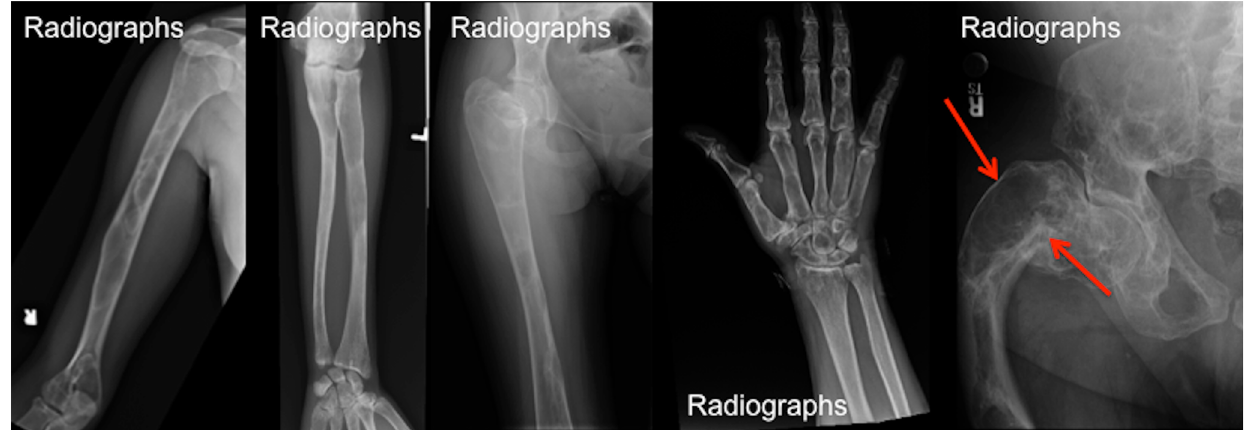
Fig. 5 The radiographic appearance of fibrous dysplasia (FD) and the rind sign. a – e Frontal radiographs demonstrate classic FD lesions in appendicular skeleton. A classic lucent lesion surrounded by a layer of